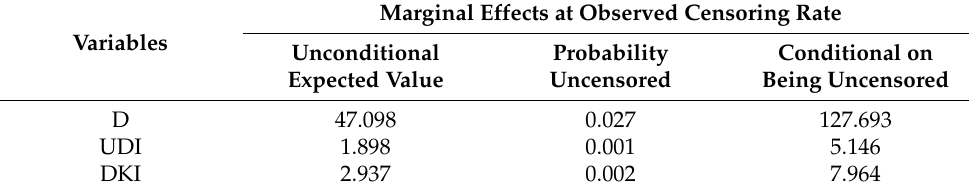
Table 6. Marginal effects of key variables on total seaweed